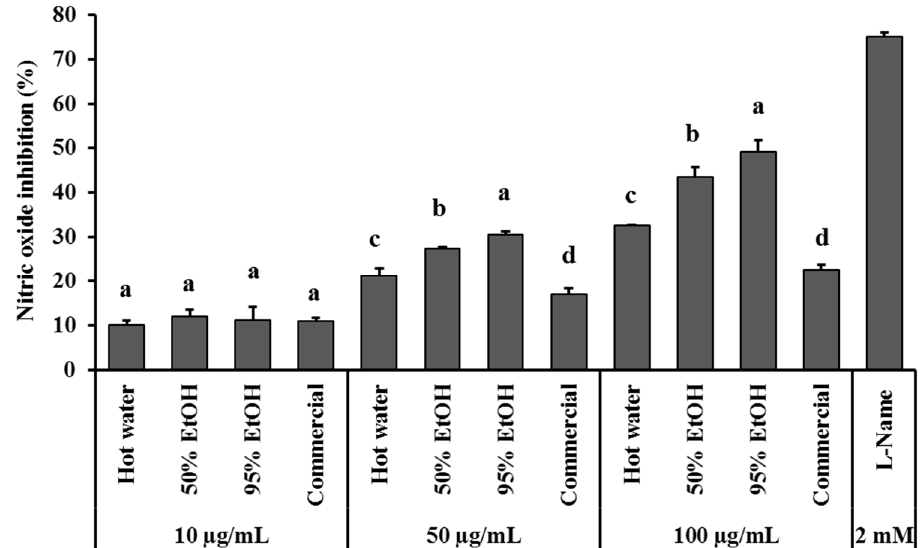
Figure 3. Effect of Phyllanthus emblica L. fruit extracts on nitric oxide (NO) inhibition in lipopolysaccharide-stimulated RAW264.7 cells. L-NG-nitroarginine methyl ester (L-Name) is a NO synthase (NOS) inhibitor used as a positive control. Data are mean ± SD ( n = 3). Values for different sample concentrations (10, 50 and 100 µg/mL) with different superscript letters (a, b, c and d) indicate a significant difference ( p < 0.05) by Duncan’s multiple range test.